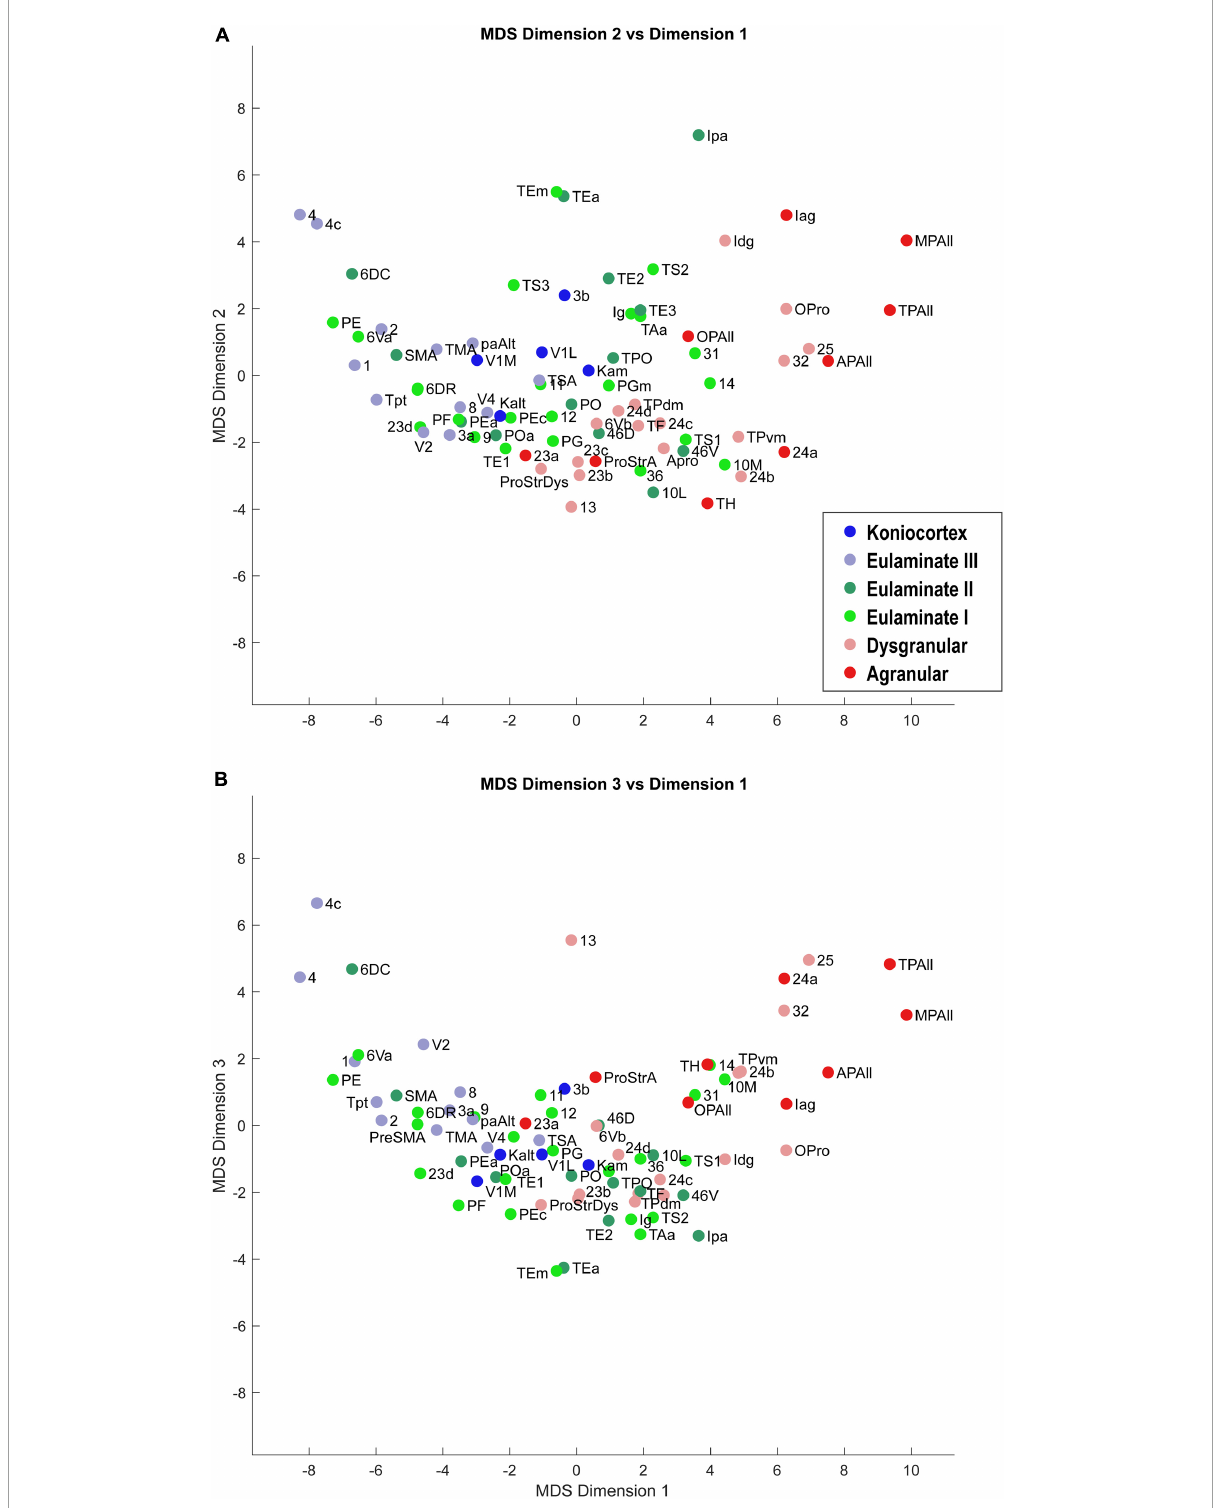
FIGURE3 Scatter plot of 78 cortical areas in MDS-derived dimensions. We used three dimensions for MDS. Dimension 1 showed the clearest alignment with the subjective classification of cortical types according to degree of lamination. (A) Dimension 2 versus Dimension 1. (B) Dimension 3 versus Dimension 1. Due to partial overlap of data points, some area labels were omitted for